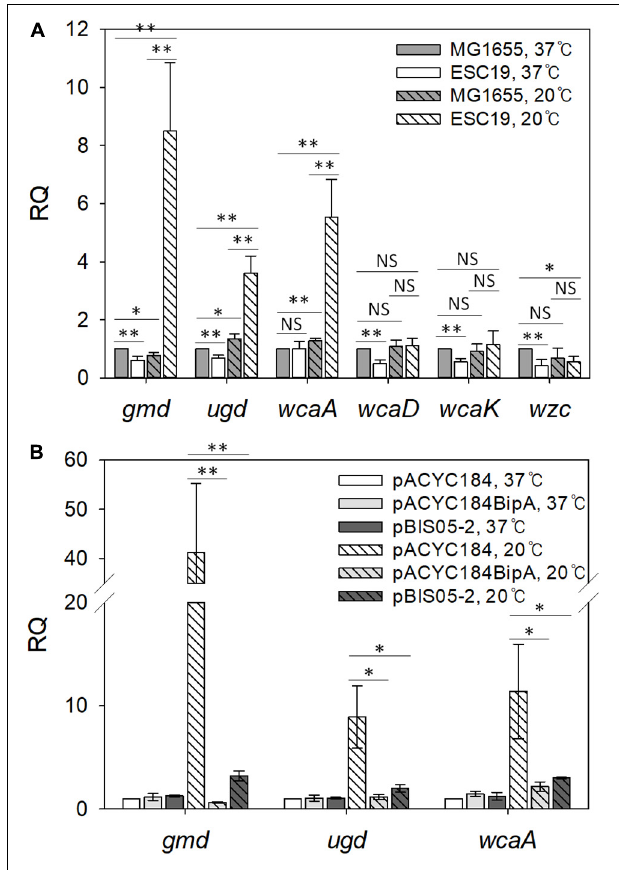
FIGURE 4 | Analysis of transcript levels of genes involved in colanic acid synthesis. (A) Quantification of transcript levels of the cps genes in MG1655 and ESC19 strains at 37 ◦ C or 20 ◦ C. Cells were grown on LB agar plates at 37 ◦ C for 18 h or at 20 ◦ C for 5–6 days, and total RNAs were extracted and analyzed using qRT-PCR for gmd , ugd , wcaA , wcaD , wcaK , and wzc transcripts. The expression levels were calculated relative to the expression level of MG1655 grown at 37 ◦ C. (B) qRT-PCR analysis of gmd , ugd , and wcaA in ESC19 transformants with pACYC184, pACYC184BipA, or pBIS05-2 at 37 ◦ C or 20 ◦ C. The expression levels were calculated relative to the expression level of ESC19 with pACYC184 grown at 37 ◦ C. The expression levels were normalized to that of the endogenous control gene gapA (glyceraldehyde-3-phosphate dehydrogenase A). Error bars denote SD. NS, non-significant; ∗ p < 0.05; ∗∗ p <